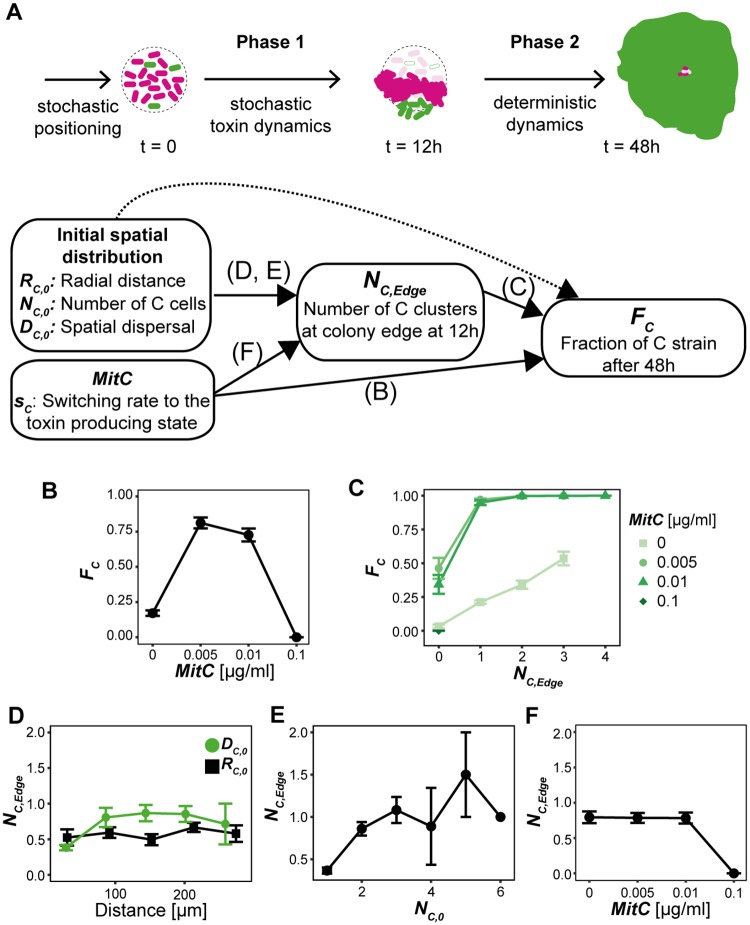
Two-phase analysis of competition outcome determinants in experiments.(A) The interaction dynamics are divided into two phases. In phase one, the stochastic switching from replication to toxin production of the ColicinE2 producer strain (C strain) determines the number of viable C clusters at the edge of the colony after 12 h, NC,Edge. In phase two, the interaction follows deterministic dynamics in which NC,Edge and MitC are suitable predictors for FC, the fraction of the C strain after 48 h, whereas the spatial initial conditions only weakly influence FC. (B) For intermediate mitomycin C (MitC) concentrations (as a proxy for toxin producer fraction), the average FC is significantly increased. (C) The NC,Edge—FC diagram grouped and colored according to MitC concentrations. (D) Dependence of NC,Edge on the average distance of C cells from the colony center RC,0 (black squares) and the average distance of C cells from the C cell center DC,0 (green circles) as proxys for initial spatial conditions. Data was binned into five equal-sized bins. (E) The relation between initial C cell number NC,0 and NC,Edge. (F) The effect of MitC concentration on average NC,Edge. (Data points show the average value, error bars denote standard error). E/F data represent the average over all four MitC concentrations.